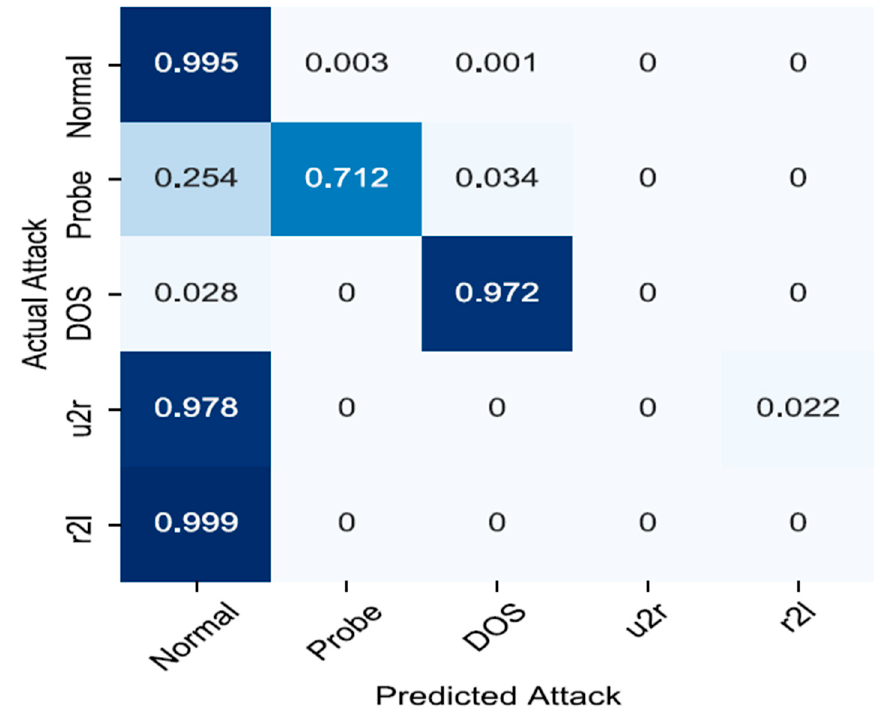
Figure 6. The performance analysis using Confusion Matrix on KDDCup-99 database.